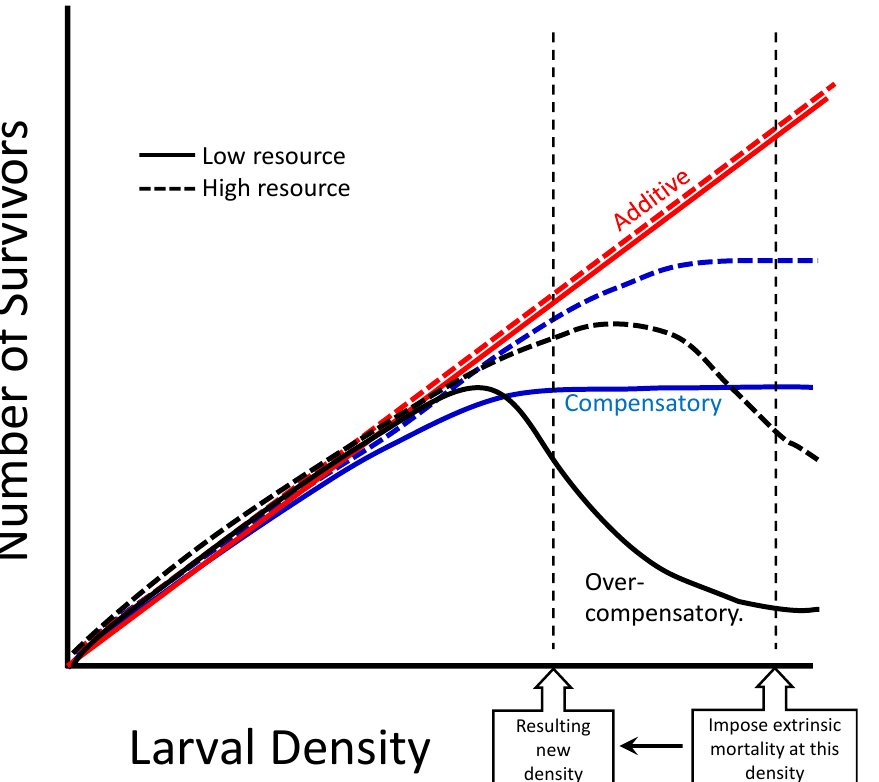
Figure 7. Postulated effects of resource levels on three relationships between initial larval density and number of survivors. Dotted and solid curves of the same color represent the postulated relationships in a relatively higher vs. lower resource environment, respectively. Additive (red): greater resource levels will not alter the result that imposing mortality would produce fewer survivors compared to not imposing mortality. Compensatory (blue): greater resource levels result in a greater asymptotic number of survivors, and could move the range of densities at which compensation occurs to greater values on the horizontal axis. Overcompensatory (black): greater resource levels result in a greater peak number of survivors and moves the density yielding that number to greater values on the horizontal axis. Imposing mortality in a higher resource environment may then produce a lesser magnitude of overcompensation relative to that produced in a low resource environment.